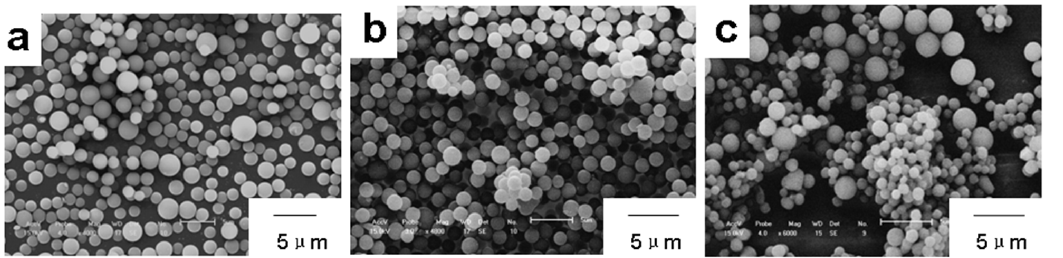
Figure 3. SEM images of polymer microspheres prepared when the molar ratio of HCCP to bi- sphenol was 1:2: ( a ) 6FPZF micro-nanospheres; ( b ) 3FPZF micro-nanospheres.